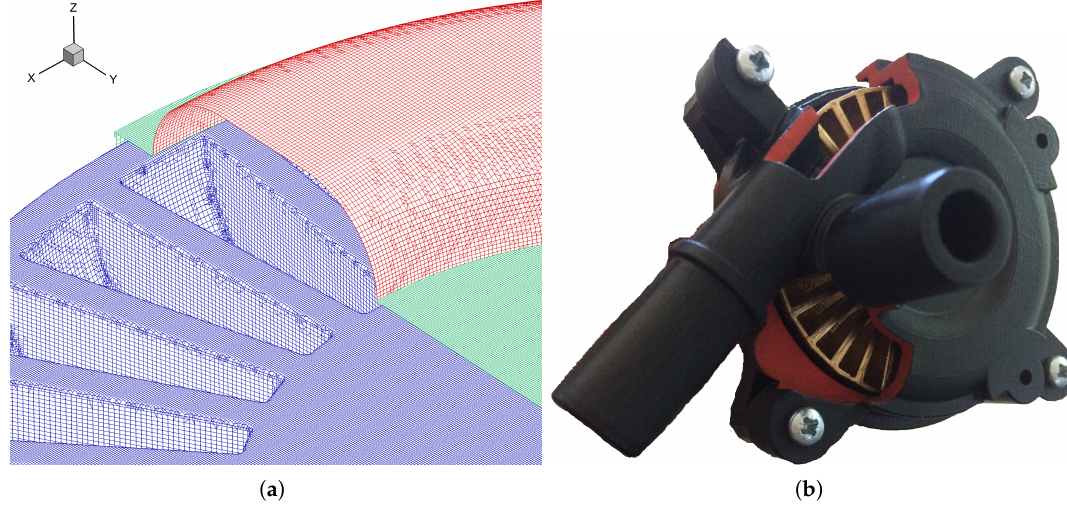
Figure 2. ( a ) Detail of the grid; and ( b ) photograph of the